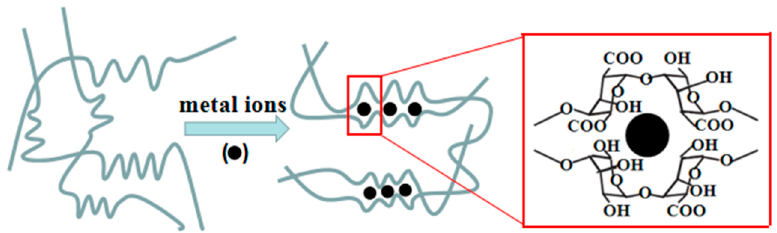
Figure 1. The crosslinking of sodium alginate—the “egg box” structure.